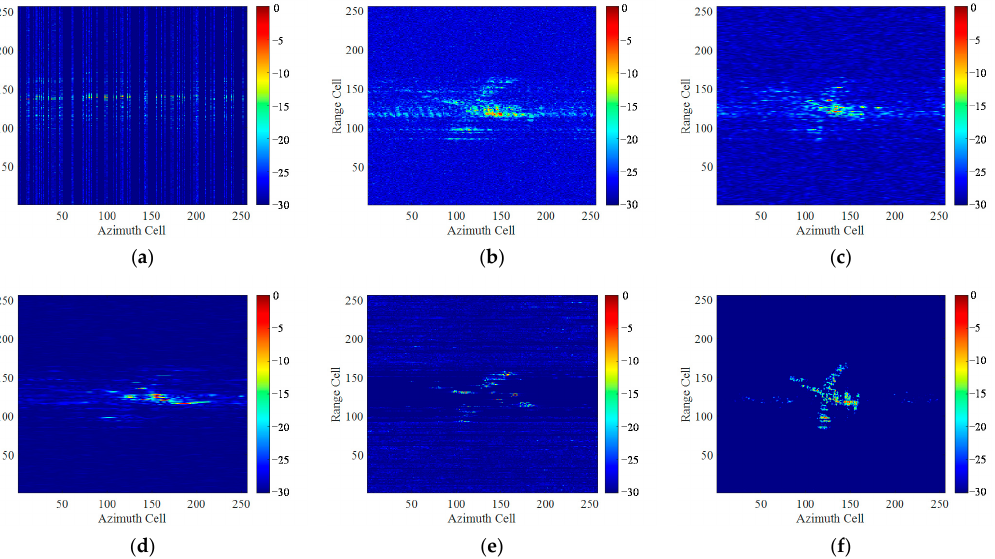
Figure 21. Imaging results of Yak-42 under 25% sampling ratio with SNR = − 10 dB by different methods: ( a ) echo after translational motion compensation; ( b ) RD algorithm; ( c ) STFT algorithm; ( d ) SPWVD algorithm; ( e ) RWT algorithm; ( f ) The proposed method.